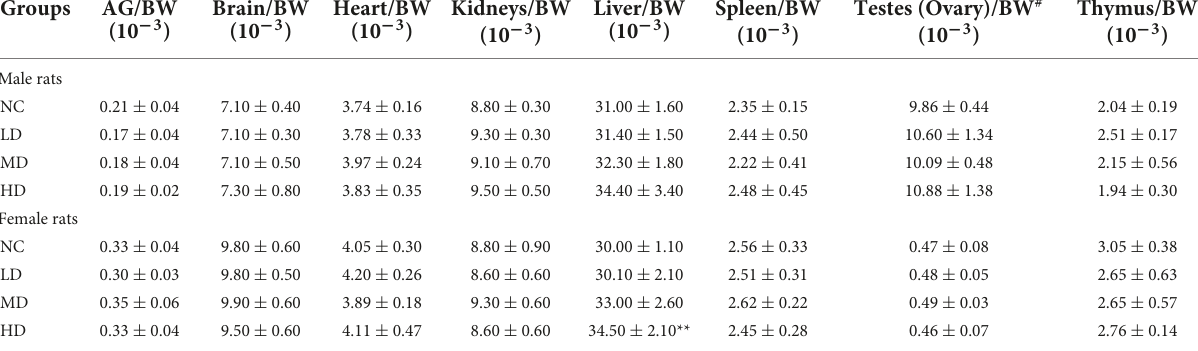
TABLE 5 Effects of aqueous extracts of Cyclocarya paliurus leaves on the organ weights of Sprague-Dawley (SD) rats in the acute toxicity study. Groups